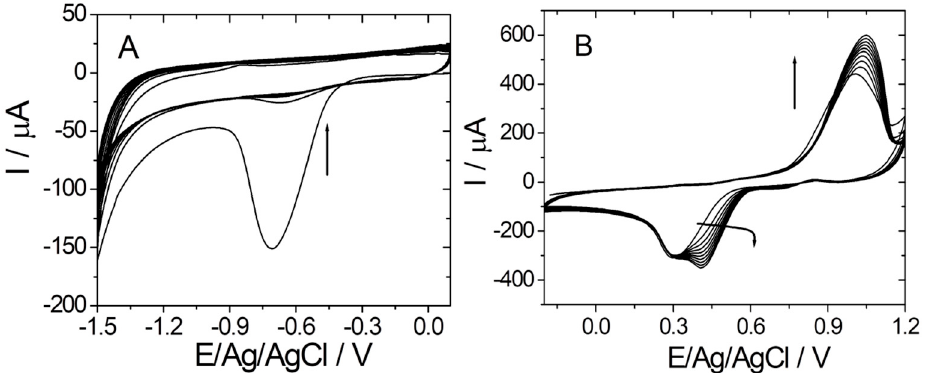
Figure 1. ( A ) Electrochemical reduction of graphene (CV in 20 mM PBS pH 7.4); 10 cycles from +0.1 to − 1.5 vs. Ag/V; 0.1 V · s − 1 ); ( B ) electrochemical deposition of gold on reduced graphene (CV in 2 mM HClO 4 solution in 0.5 M H 2 SO 4 ; 10 cycles from − 0.2 to +1.2 vs. Ag/V; 0.1 V · s − 1 ).